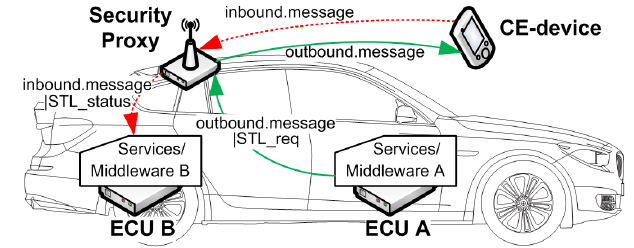
Figure 3. STL life